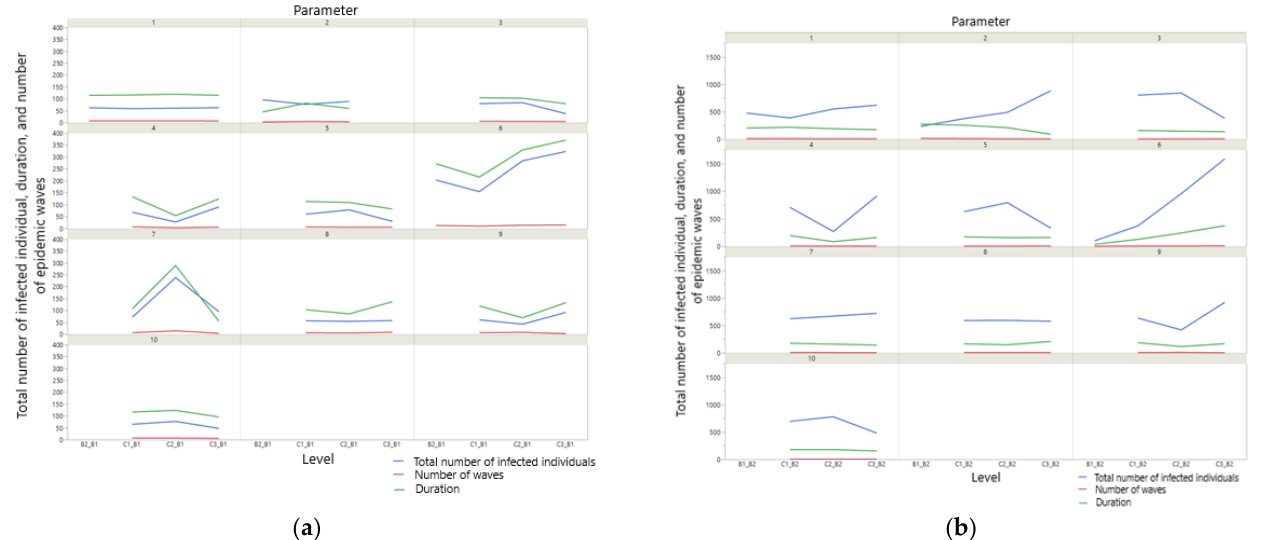
Figure 8. Summary of output responses means per baseline level: ( a ) low-level baseline; ( b ) high-level baseline.